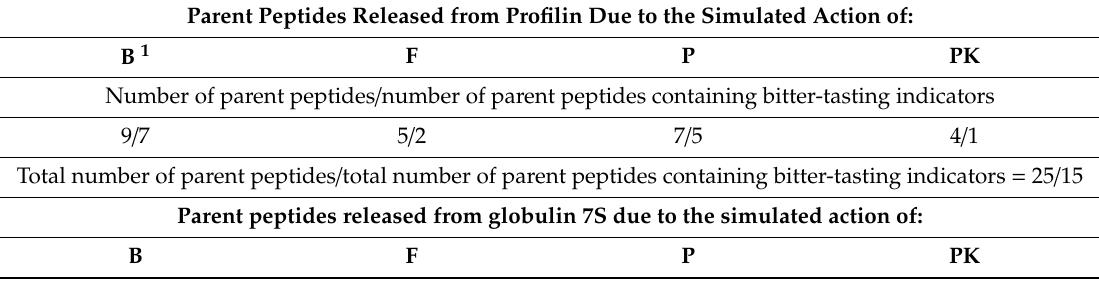
Table 1. Number of parent peptides including these containing bitter-tasting indicators found in soybean protein